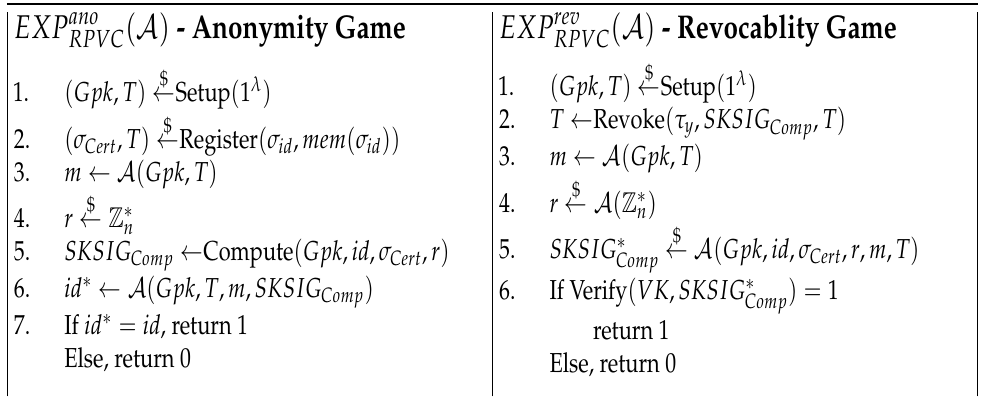
Figure 3. Security Games for RPVC.